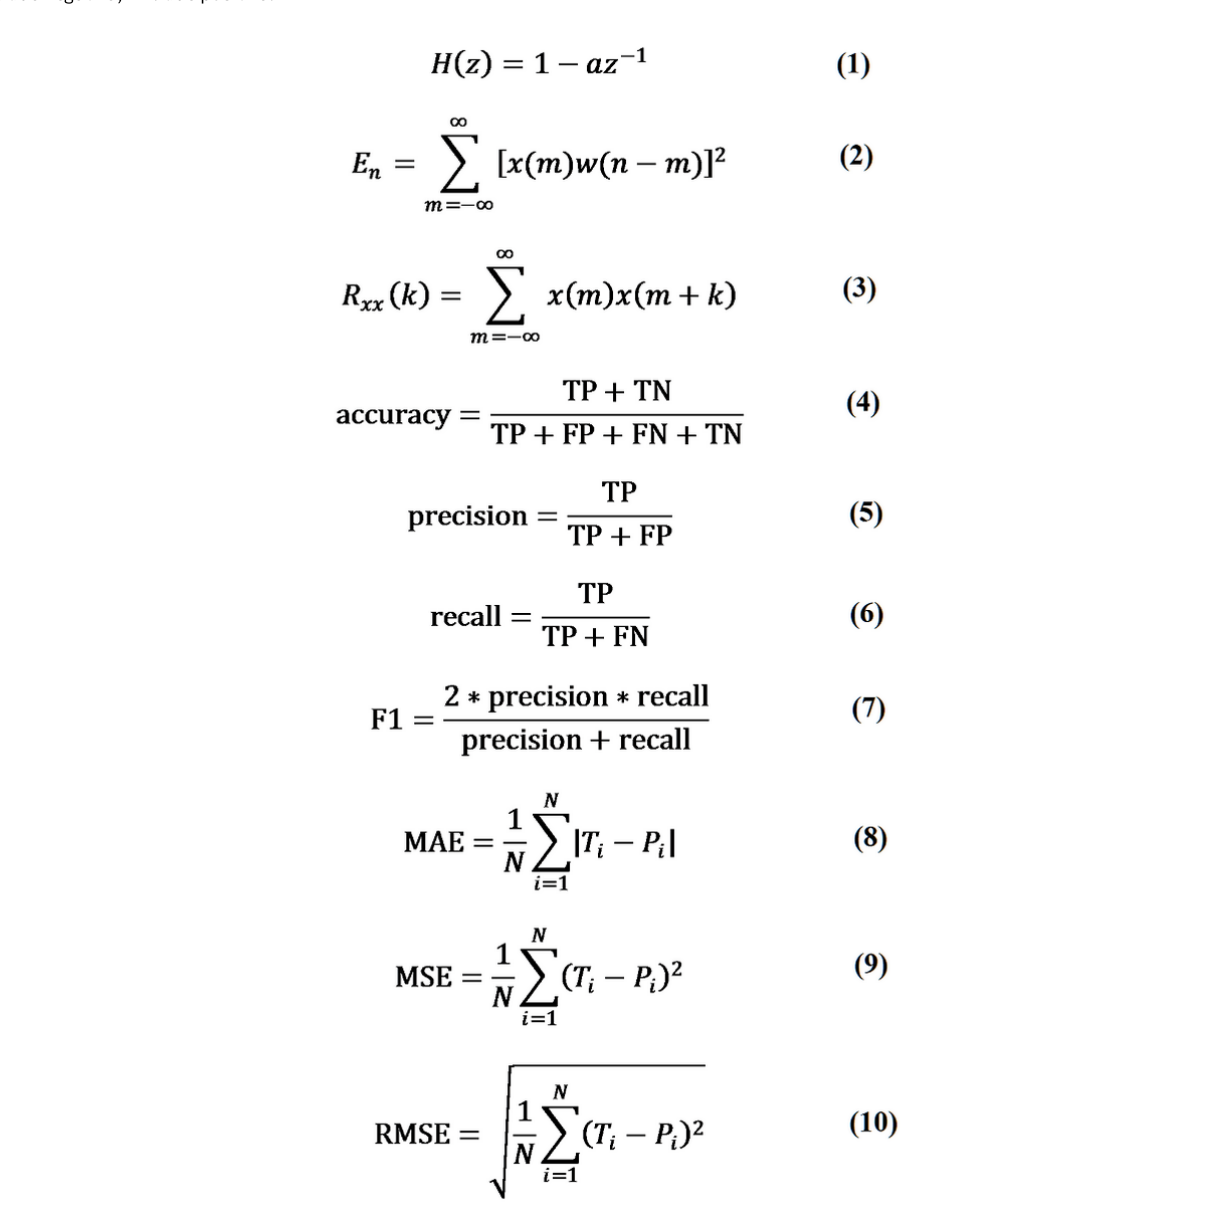
Figure 1. Equations 1-10. FN: false negative; FP: false positive; MAE: mean absolute error; MSE: mean square error; RMSE: root mean square error; TN: true negative; TP: true